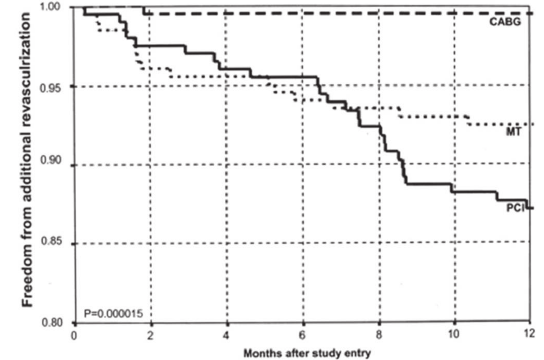
Fig. 1 - Sobrevivência livre de eventos, ao final de um ano entre CRM (CABG), ATP (PCI) e tratamento clínico (MT) Tabela 1. Evolução após um ano, dos três grupos randomizados – Tabela extraída da referência 15, com autorização da